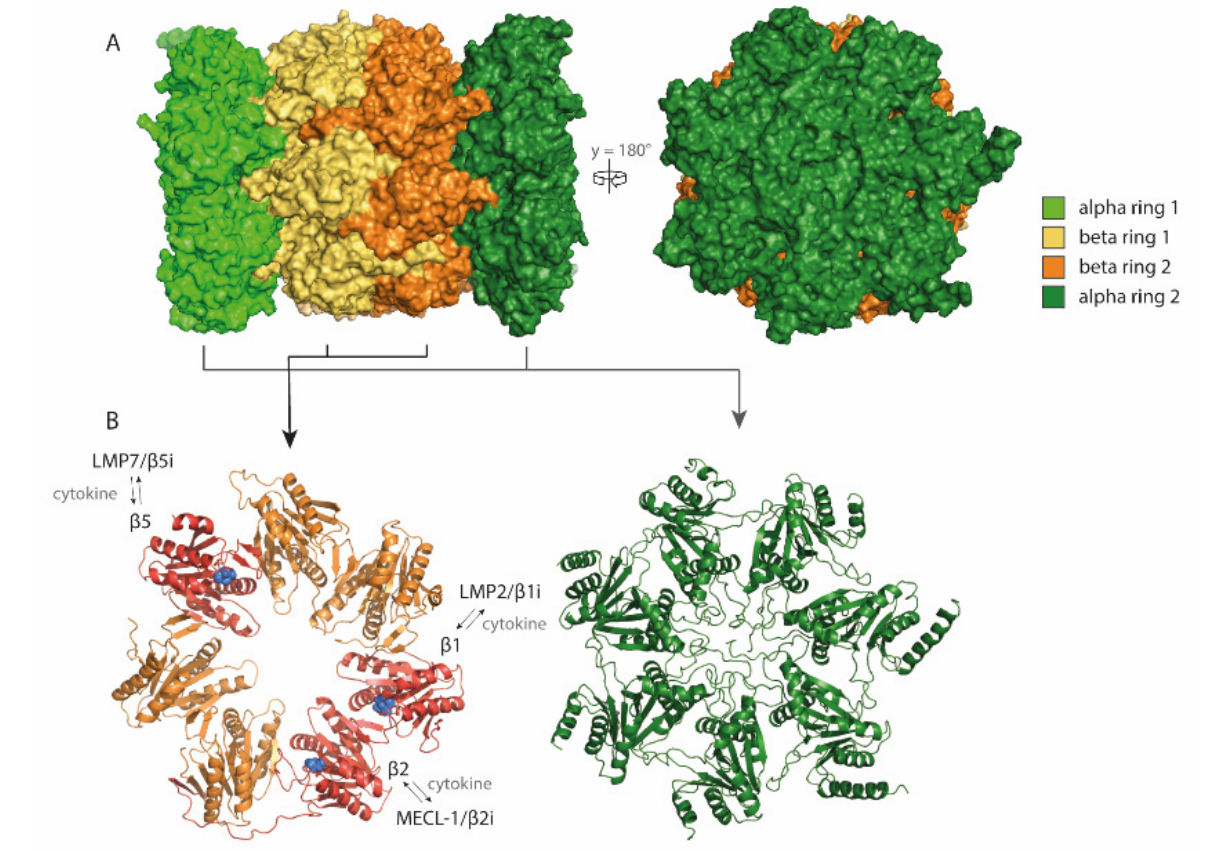
Figure 1. The 20S proteasome consists of two alpha and two beta rings, together forming a barrel-like particle. ( A ) Four rings of the proteasome complex stacked to form a barrel-like particle, alpha and beta rings depicted in green and yellow/orange, respectively; ( B ) Each proteasome ring consists of seven subunits: α 1-7 for alpha rings and β 1-7 for beta rings. Catalytic subunits are shown in red with catalytic sites indicated (blue spheres). This figure is based on the human proteasome structure: PDB file 5L4G [8].